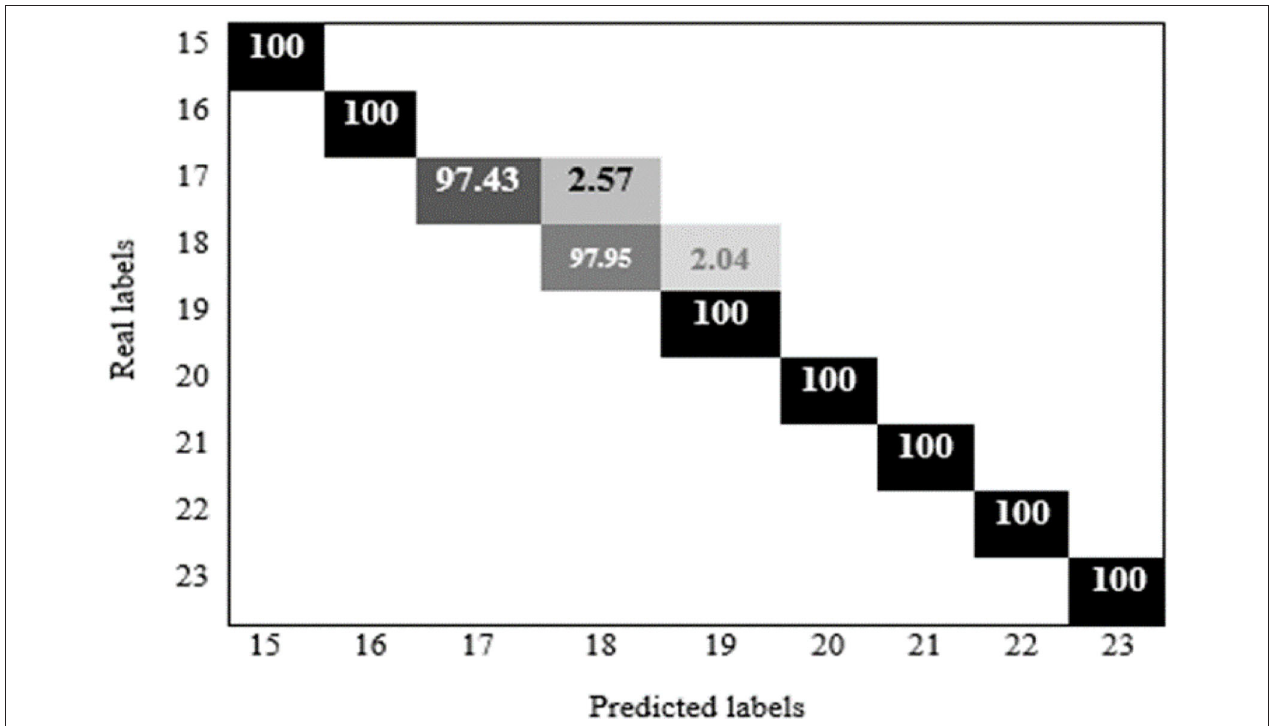
FIGURE 8 | Confusion matrix of hybrid HCNN-KNN proposed model application on enhancement